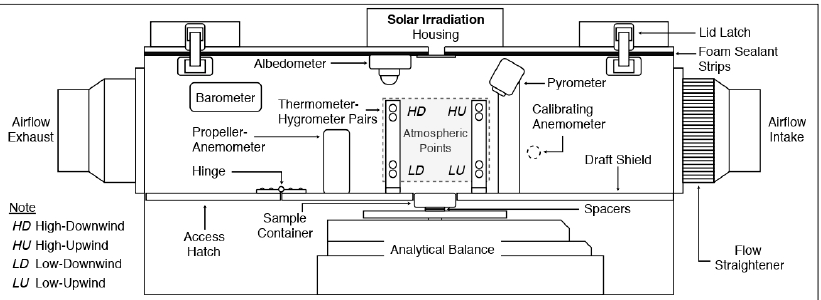
Figure 1 . System layout of bench-scale atmosphere simulator.